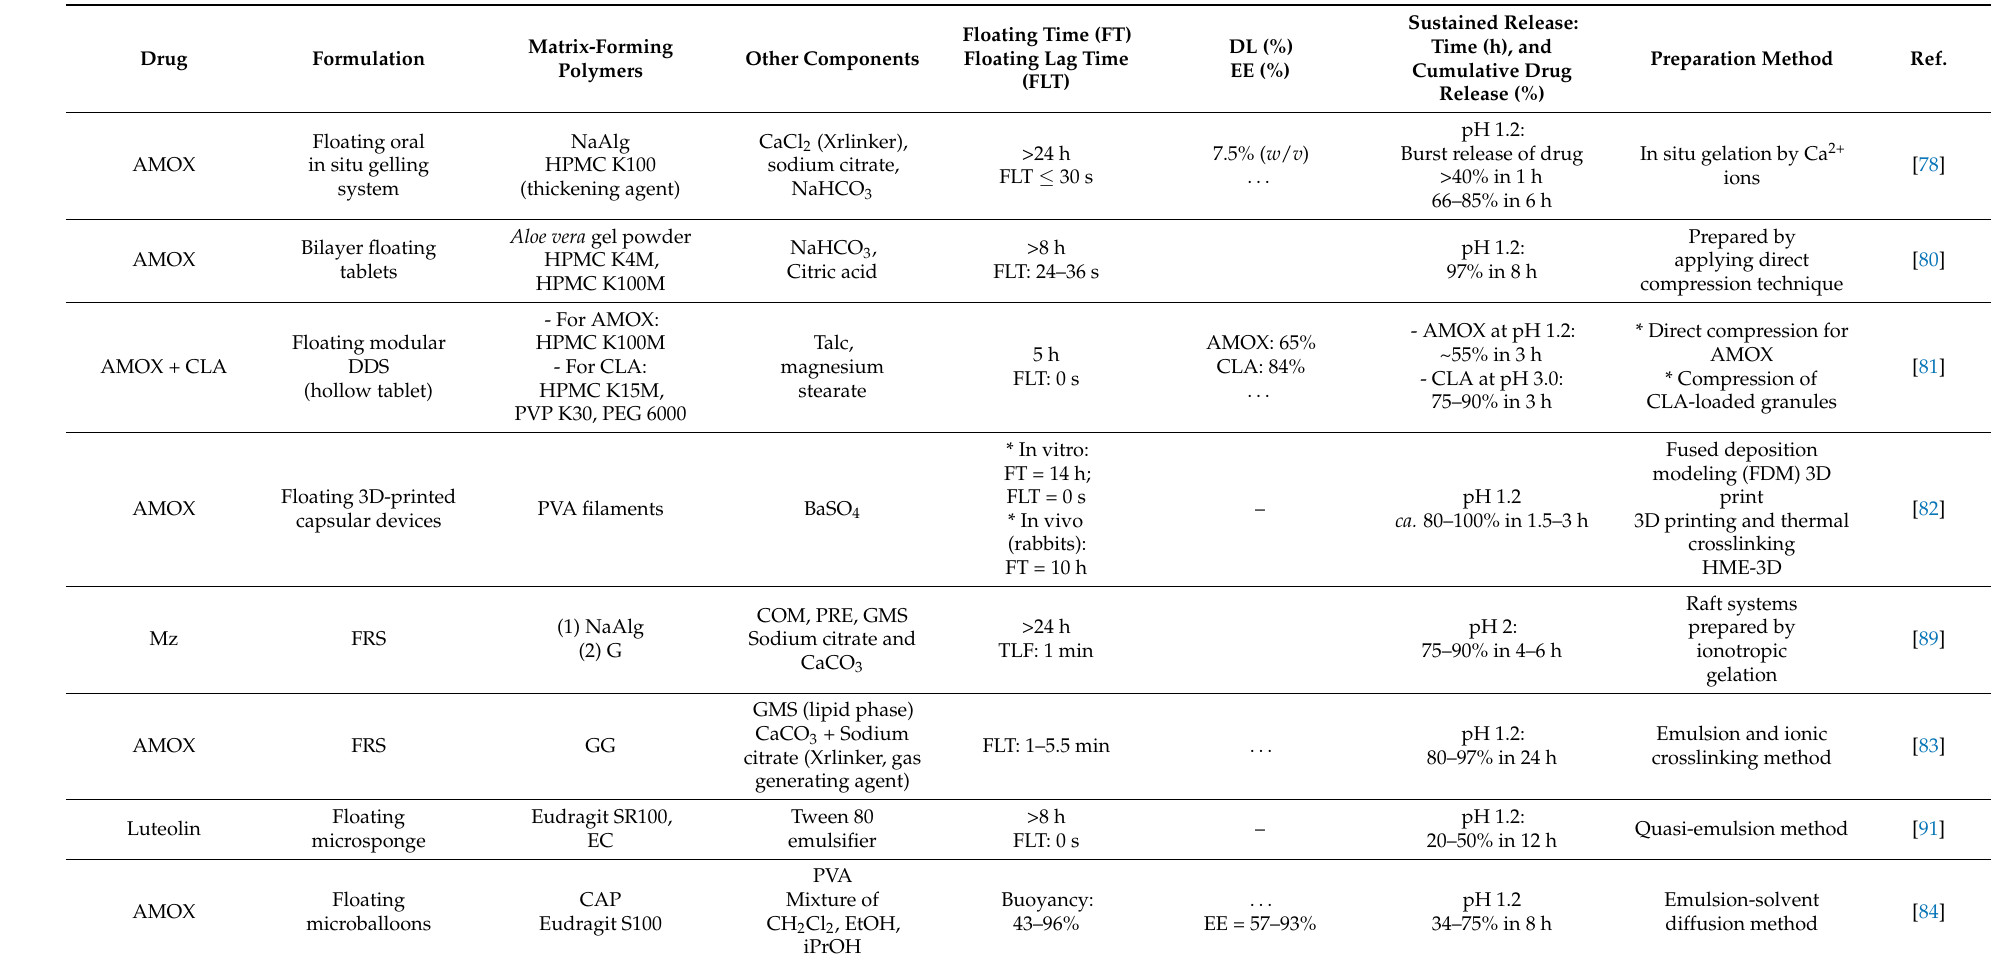
Table 2. Selected AMOX-loaded floating formulations used in the treatment of infections by H. pylori